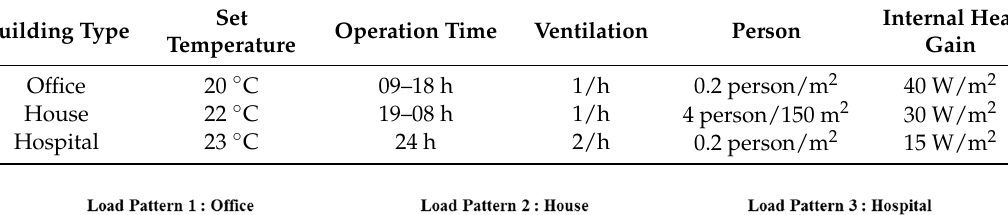
Figure 9. Three load patterns for example.